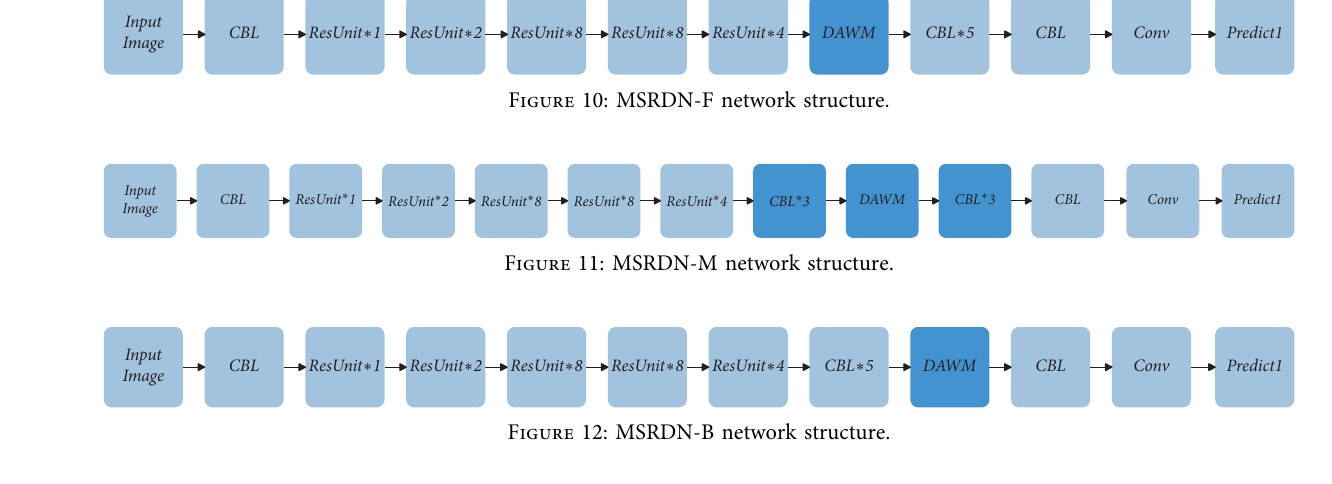
Figure 10: MSRDN-F network structure.